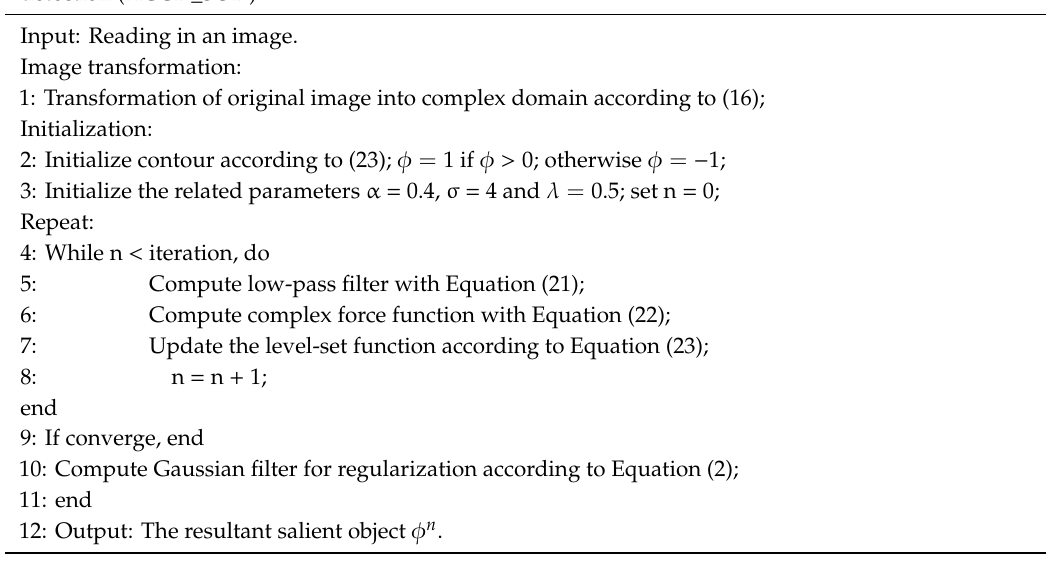
Algorithm 1. Steps for our proposed algorithm active contours in the complex domain for salient object detection